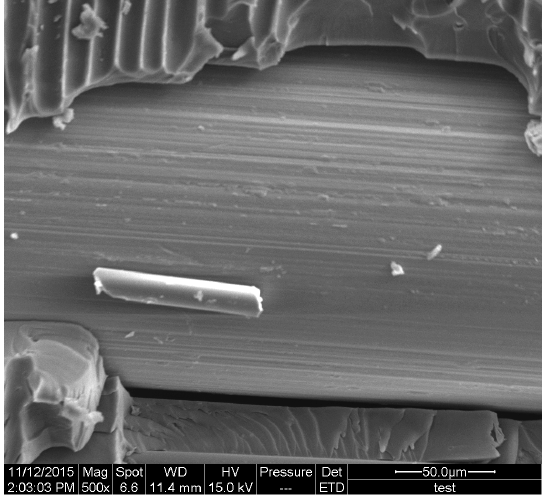
Figure 7. SEM micrographs of SMA in the composites after flexural damage.